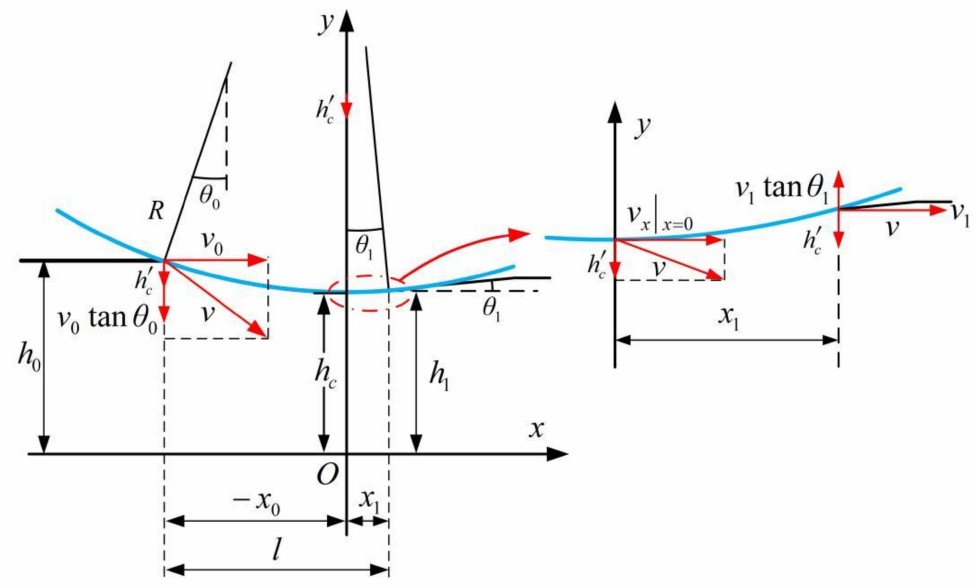
Figure 4. Changes of velocity and velocity components on the surface of the strip in the deformation